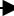
Fig. 6a–d. Examples of simultaneous observations by two spacecraft skimming along the dayside oval: a,b spacecraft trajectories for 2 episodes on August 12, 1979. Segments of the orbit with isotropic precipitation of 30 keV protons shown by circles , positions of isotropic boundaries by crosses , the cosine approximation of isotropic boundary shape is also shown by the solid line on each plot c,d Particle characteristics neasured by TIROS and NOAA6 during the first episode (trajectories shown in Fig. 4A). From top to bottom : count rate of ~1 keV proton flux; channel number which gives largest contribution to the energy flux of precipitated electrons (numbers 1 to 11 correspond to energies from 0.3 keV to 20 keV); count rates of trapped and precipitated fluxes of energetic particles ( P corresponds to protons at >30 and >80 keV, and E electrons with E >30 keV)